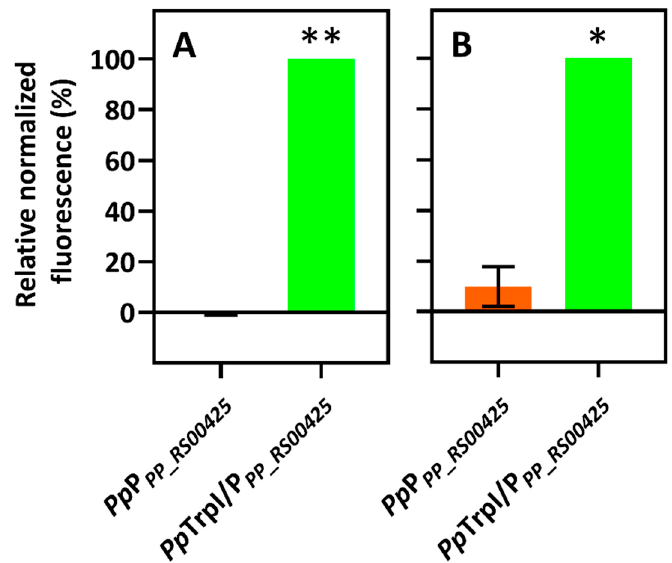
Figure 2. Comparison of biosensors containing Pp TrpI/P PP_RS00425 and Pp P PP_RS00425 systems. Measurements were carried out using E. coli- ( A ) and C. necator ( B )-based biosensors grown in MM and supplemented with 1 mM of indole as an inducer or without inducer. Figure displays relative normalized fluorescence values (in %) at 10 h after supplementation with indole. Data are mean ± SD, n = 3. Asterisks indicate a statistically significant increase of fluorescence in the samples supplemented with inducer comparing to samples without the ligand (** p < 0.01, * p < 0.02 unpaired two-tailed t -test).